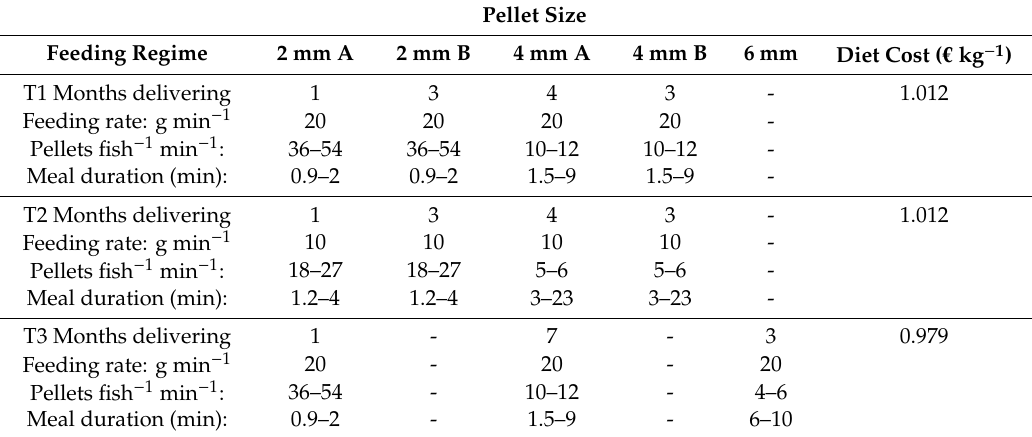
Table 3. Feeding schedule and cost of the feed for the di ff erent experimental feeding regimes. Diet cost is the weighed cost of each feeding regime according to the amount of feed of each type